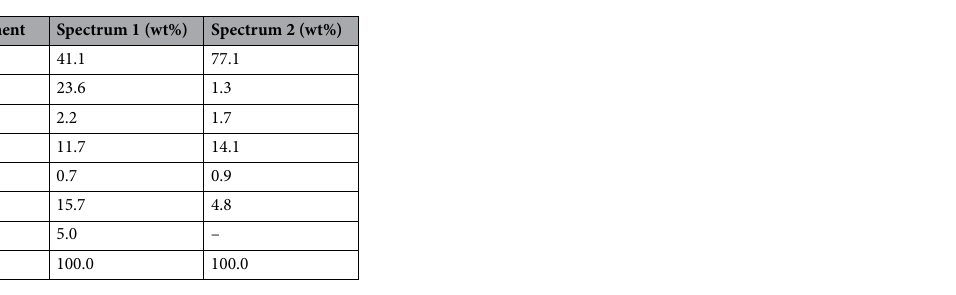
Table 3. EDX analysis of corresponding spectra shown in the worn EBM-processed high carbon martensitic stainless steel at 10 N.